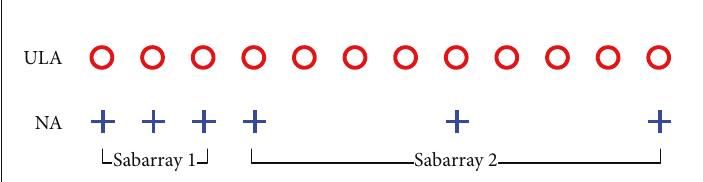
Figure 1: The nested array structure.